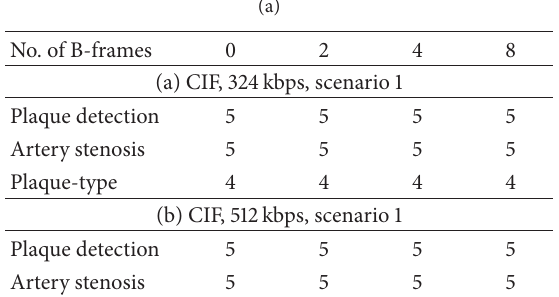
Table 6: (a) Clinical evaluation of scenario 1 (WLAN). (b) Clinical evaluation of scenario 2 (HSPA).